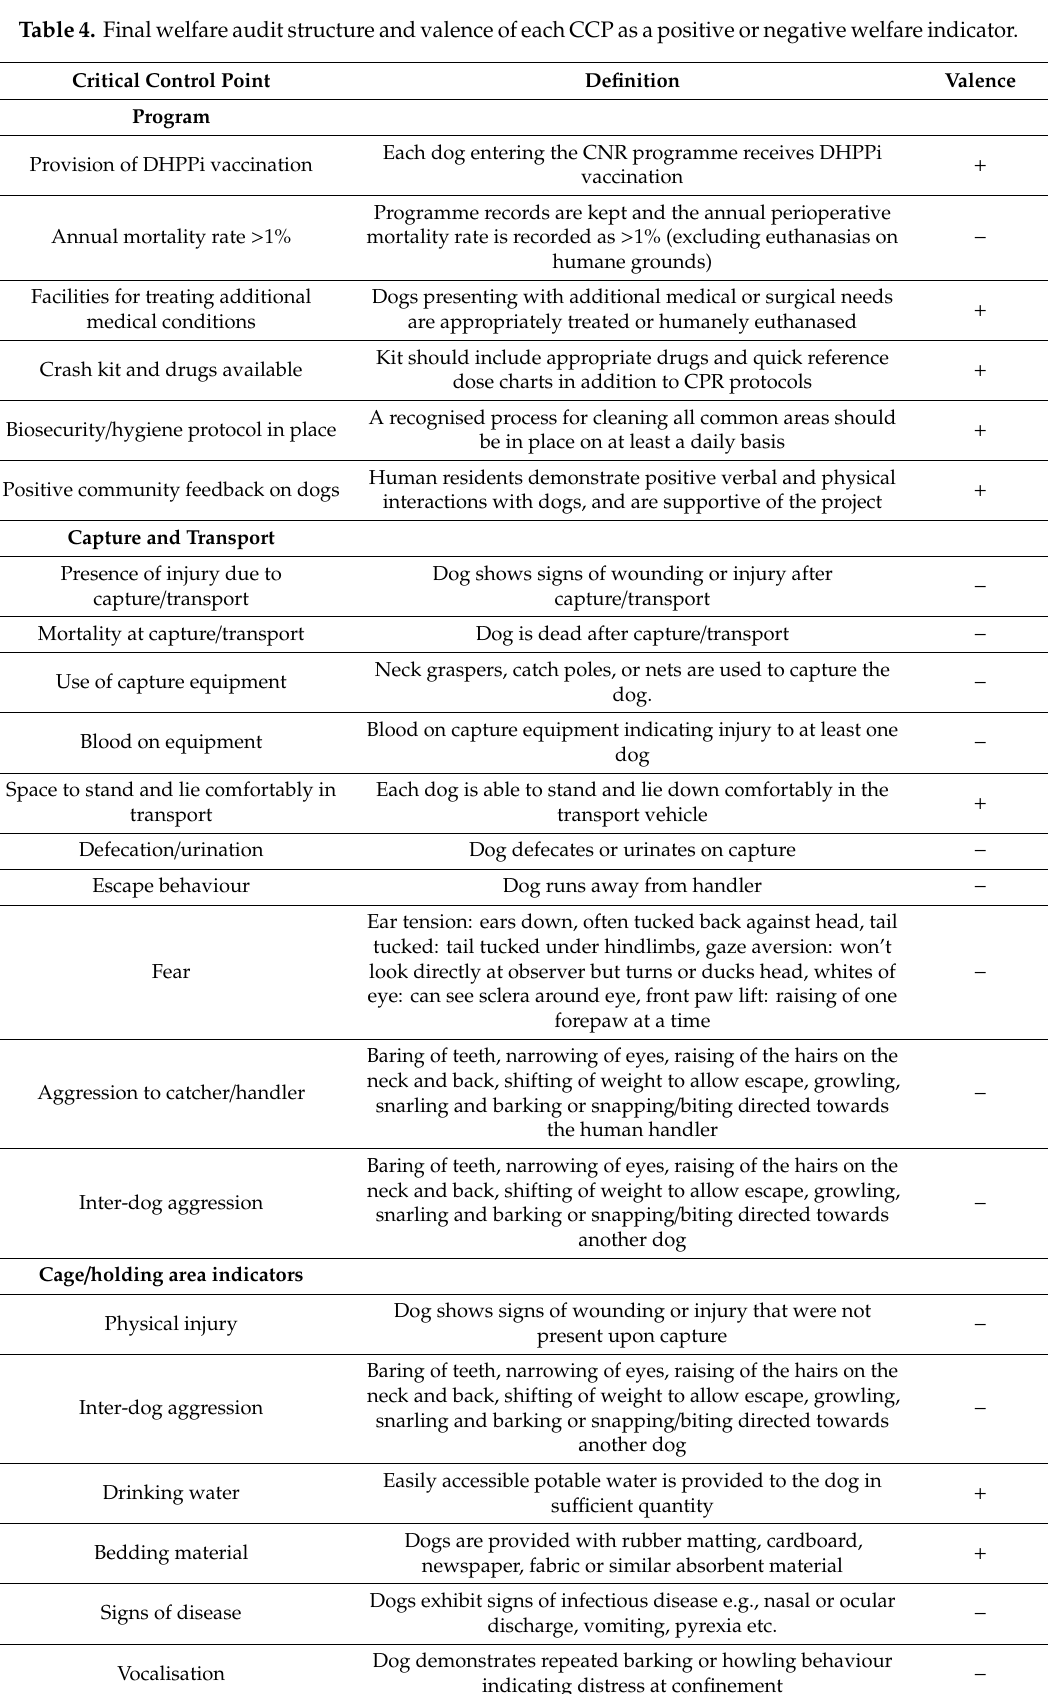
Table 4. Final welfare audit structure and valence of each CCP as a positive or negative welfare